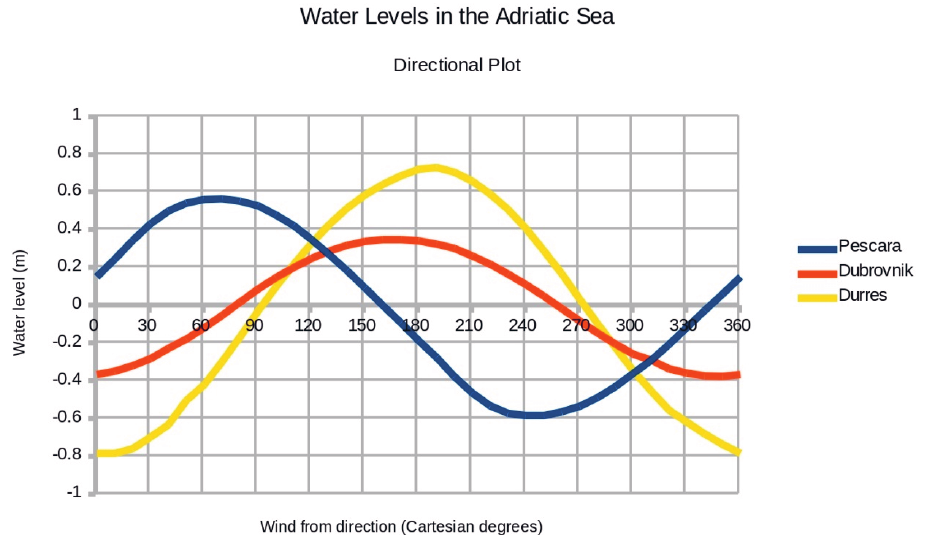
Figure 11. Directional plot for Pescara, Dubrovnik, and